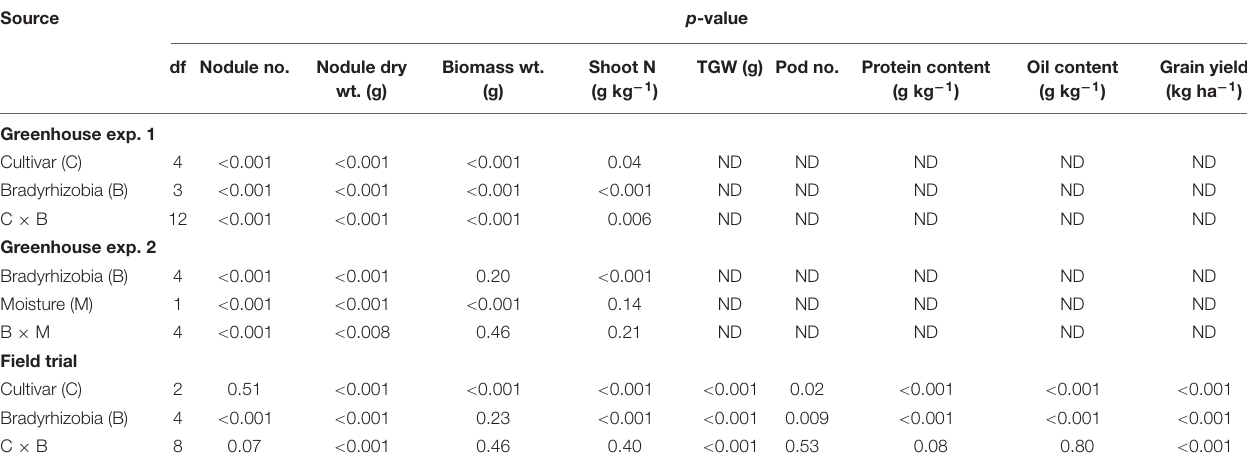
TABLE 4 | Summary of ANOVA for the influence of cultivar, bradyrhizobial type, moisture and their interrelations on nodulation and yield in the two greenhouse experiments and field trial. Source